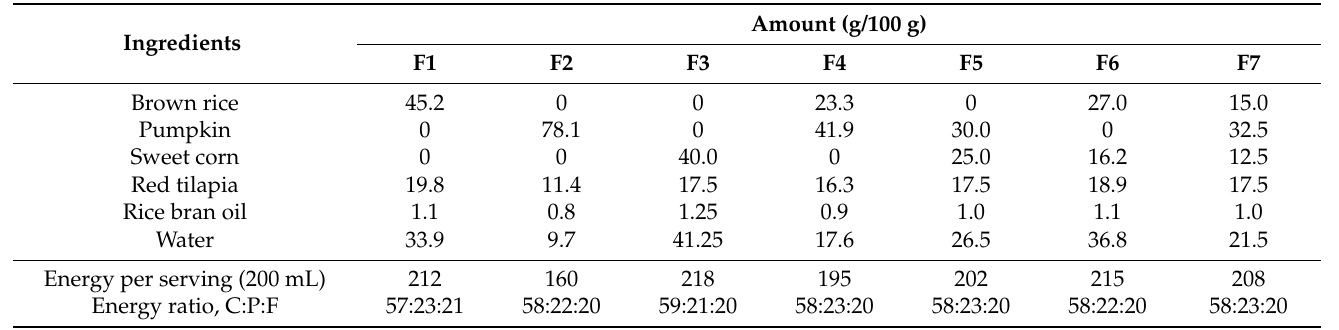
Table 1. Soup formulations by varying carbohydrate ingredients based on a recommended macronu- trient energy